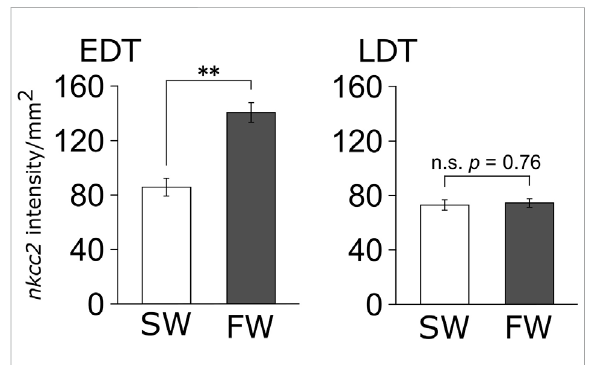
FIGURE 4 Signal intensity of nkcc2 mRNA expressions in EDT and LDT. The signals of nkcc2 mRNA expression in the EDT (left panel) and LDT (right panel) were quanti fi ed with ImageJ. Open and fi lled columns represent SW control and FW-acclimated individuals, respectively. N = 4 in each group. Statistically signi fi cant difference between SW and FW is shown with asterisks (** p < 0.01). FIGURE 5